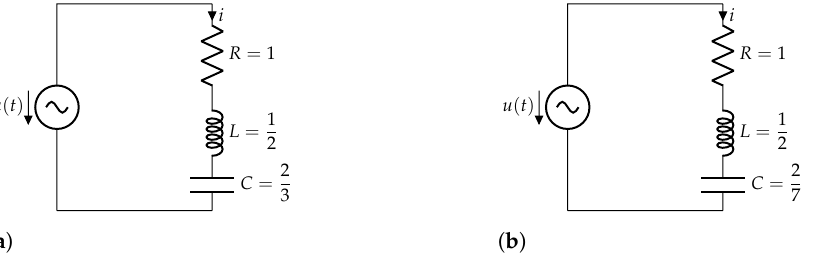
Figure 2. Two RLC circuits are used for Example I. They are very similar (same series RLC ) but differ in the values of the capacitor, i.e., C = 2/3 F for circuit ( a ) and C = 2/7 F for circuit ( b ), so the reactive power provided by the source is also